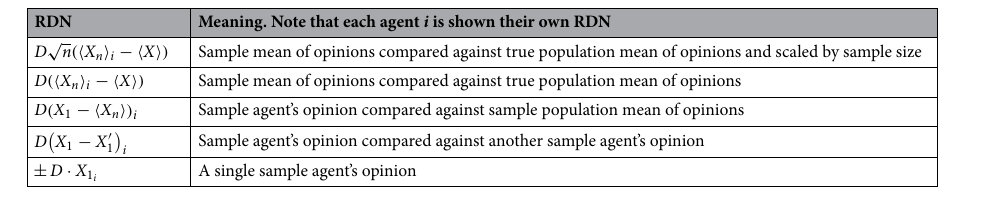
Table 1. Different RDN terms yielding similar results.